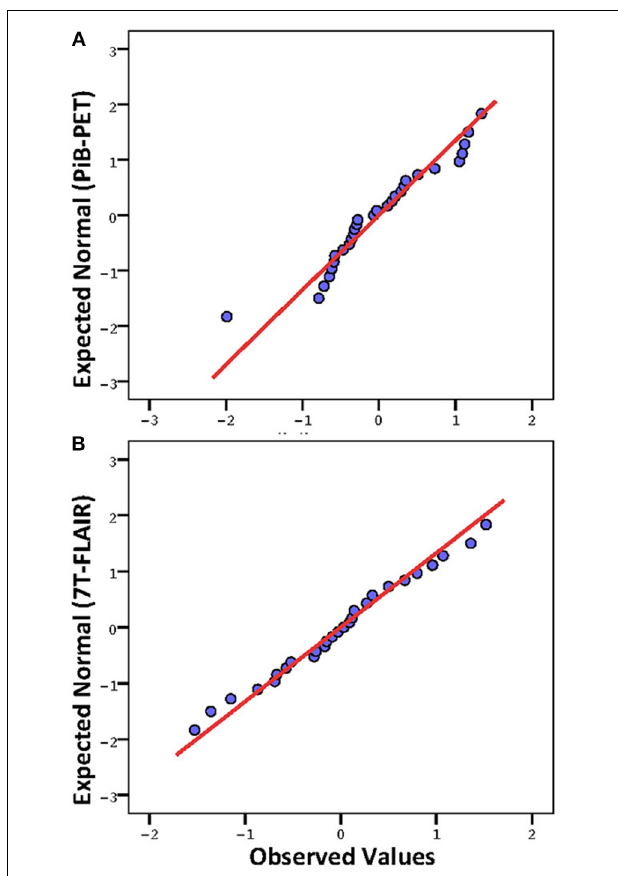
FIGURE 1 | Q-Q Plots of mean regional intensities (standardized z-scores; 0 = mean, values indicate standard deviations from mean). (A) Pittsburgh Compund-B positron emission tomography; (B) Fluid-attenuated inversion recovery (FLAIR) 7 Tesla MRI